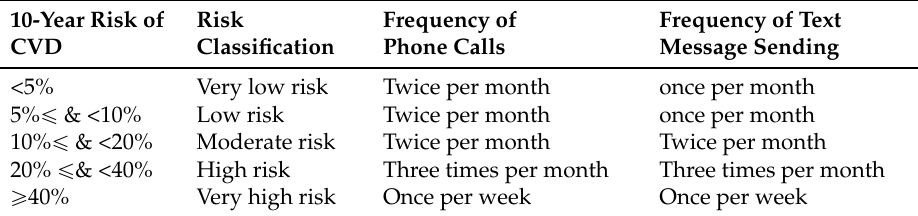
Table 1. The frequency of phone calls and text